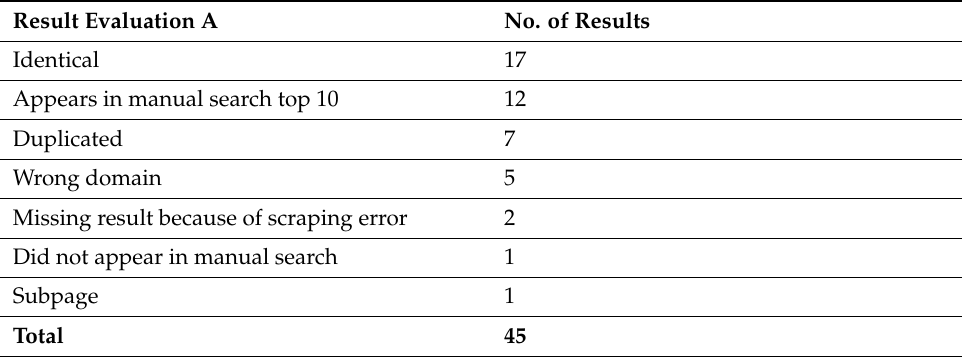
Table 2. Results evaluation